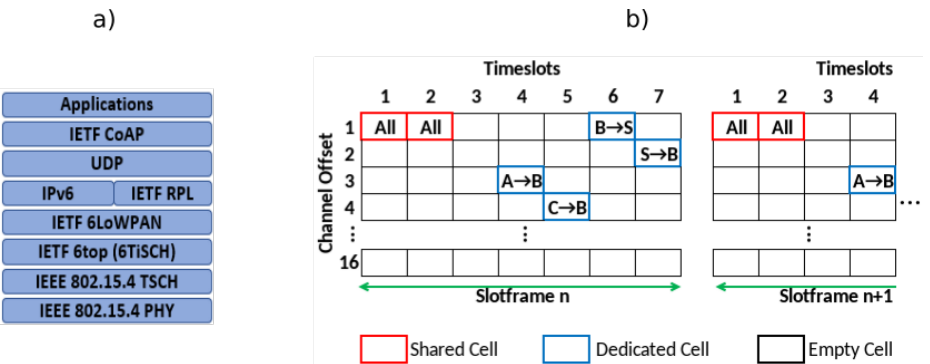
Figure 1. ( a ) 6TiSCH Protocol Stack ( b ) Time Slotted Channel Hopping